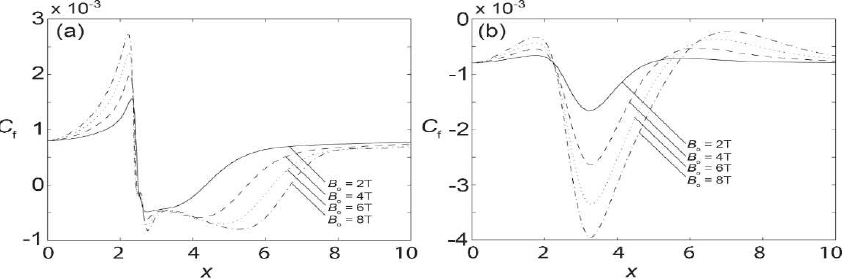
Figure 8. Skin friction coefficient along the channel when subjected to various magnetic field intensi- ties at Re = 250: ( a ) lower wall; and ( b ) upper